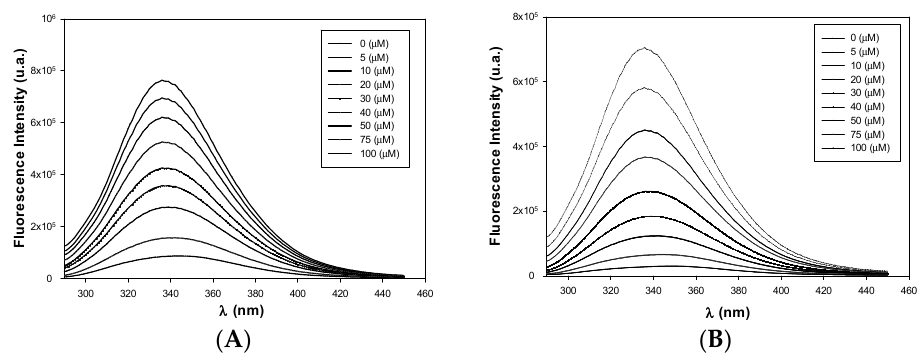
Figure 9. Fluorescence spectra of BSA in the presence of ( A ) naringin and ( B ) VONarg in Tris–HCl buffer of pH 7.4 at 298 K. BSA (6 μ M), naringin and VONarg (0–1.00 μ M).